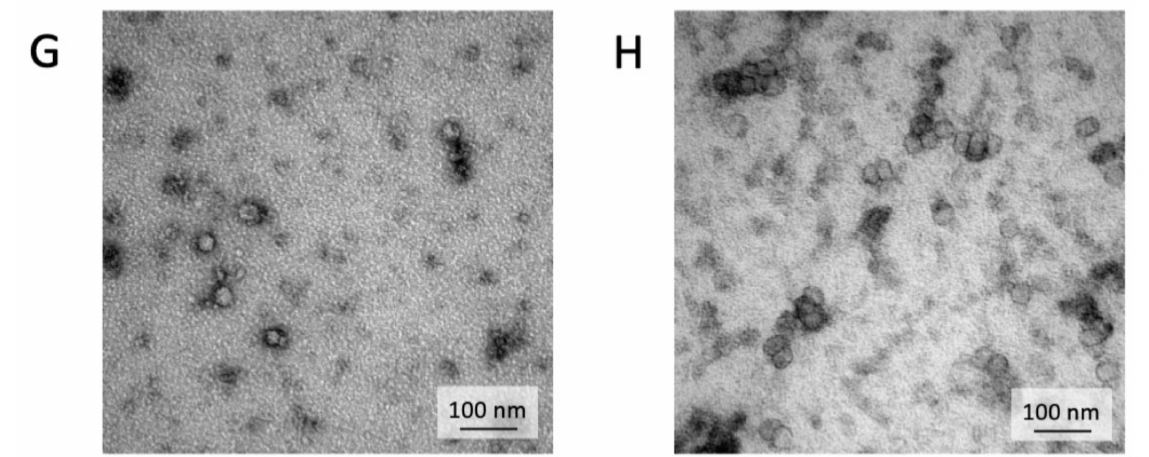
Figure 1. Exosome characterization: ( A ) average size of exosome diameters from young (exoY) and old (exoO) donors, ( B ) presence of CD63 on exoY, ( C ) presence of CD81 on exoY, ( D ) presence of CD63 on exoO, ( E ) presence of CD81 on exoO, (F) % of presence of specific markers of exosome derived from MSCs by gene expression; TEM of exosomes from young ( G ) and old ( H ) donors.